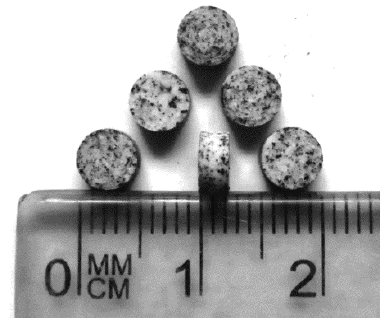
Figure 4. Solid-state hydrogen-generating composite based on sodium borohydride.